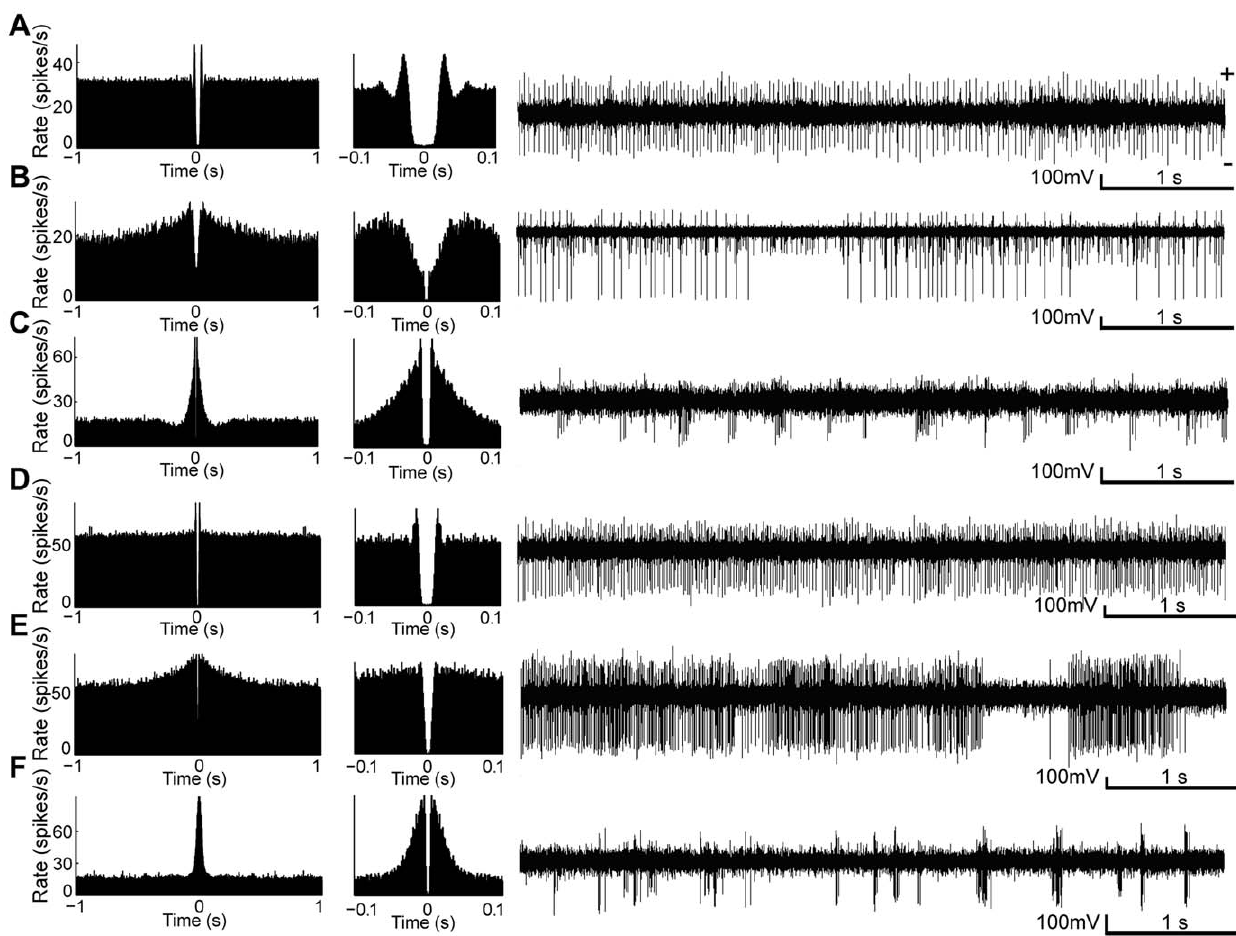
Figure 2. Typical firing patterns observed in rats (A–C) and primates (D–F). Left panel: autocorrelation using a time window of 6 1 s, middle panel: autocorrelation with x-axis expanded to 6 0.1 s, right panel: spike train of the example neuron. A: example of HFP neuron exhibiting tonic Poisson firing without pauses. B: HFP neuron displaying pauses (pauser). C: LFB neuron (burster). D–F: same type of neurons as in A–C but in primates.